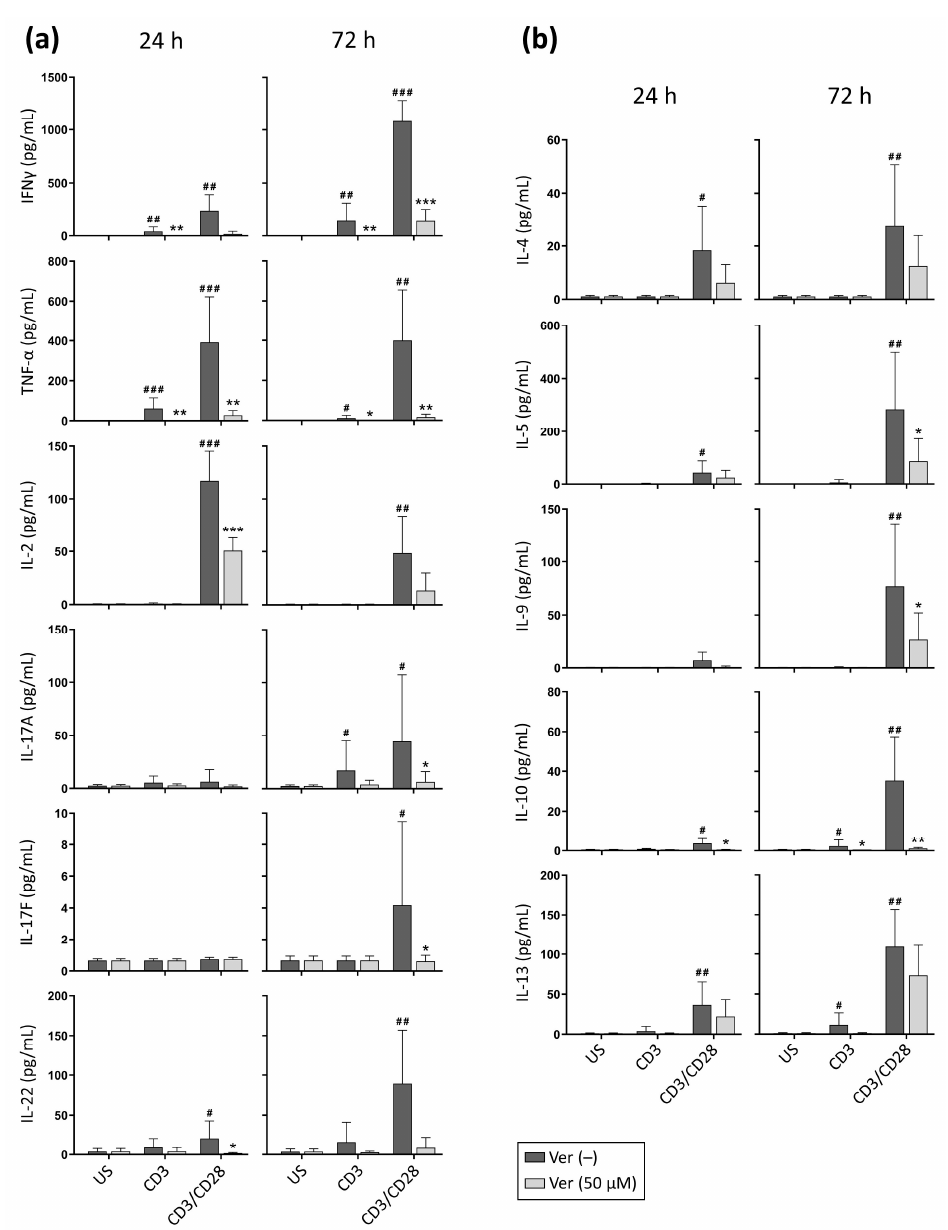
Figure 3. Verapamil decreases the production of Th1/Th17 and Th2 cytokines by T cells. Purified T cells were stimulated (CD3 alone or CD3/CD28) in the absence or presence of verapamil (50 µ M). After 24 and 72 h of culture, cell supernatants were collected, and ( a ) Th1/Th17 (IFN γ , TNF- α , IL-2, -17A, -17F, and -22) and ( b ) Th2 (IL-4, -5, -9, -10, and -13) cytokines were quantified with a multiplex assay. Data from 6–12 donors are shown as mean + SD. The significance of the pairwise comparisons between unstimulated and stimulated (CD3 alone or CD3/CD28) cells is indicated with hash signs ( # p < 0.05, ## p < 0.01, ### p < 0.001). The significance of the pairwise comparisons between cells cultured without and with verapamil is indicated with asterisks (* p < 0.05, ** p < 0.01, *** p <